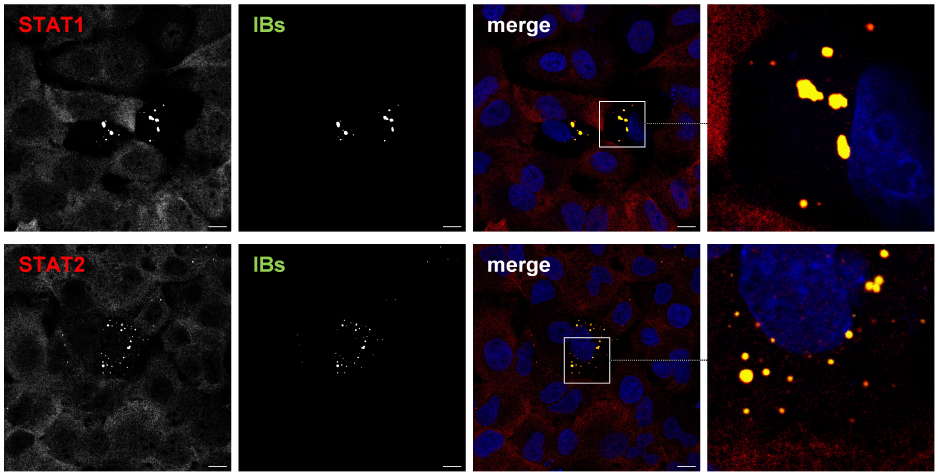
Figure 2. NiV N/P inclusions sequester STAT proteins. A549 cells were transfected with plasmids encoding NiV N and NiV PeGFP, the minimal requirement to induce the formation of cytosolic IBs. After 24 h, cells were fixed with PFA, permeabilized with Triton X-100 and endogenous STAT1, and STAT2 proteins were stained with specific antibodies (red). Inclusion bodies (IBs) were detected by eGFP autofluorescence (green). Nuclei were counterstained with DAPI (blue). Greyscale single- channel images and colorized merged images are shown. Boxed areas are displayed in a higher magnification and show the STAT accumulation in IBs in a NiV N/P-expressing cell. Scale bars, 10 µ